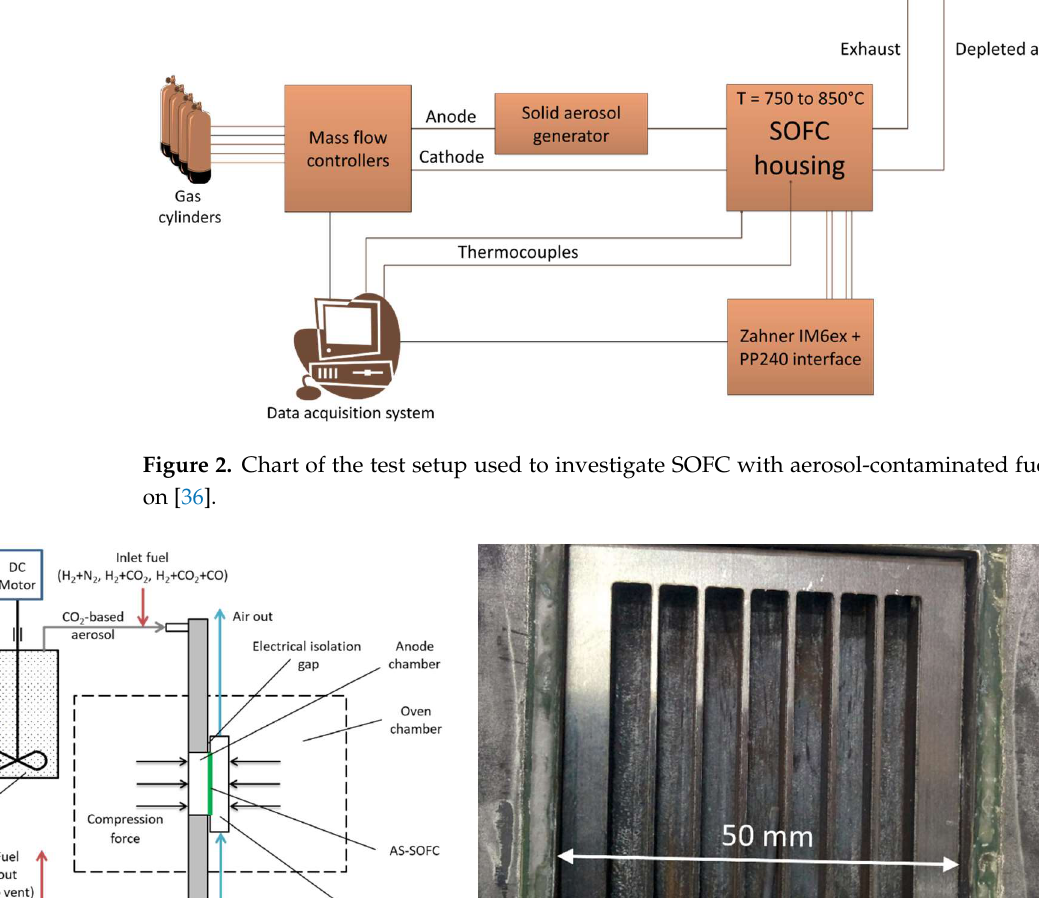
Figure 2. Chart of the test setup used to investigate SOFC with aerosol-contaminated fuel, based on [36].